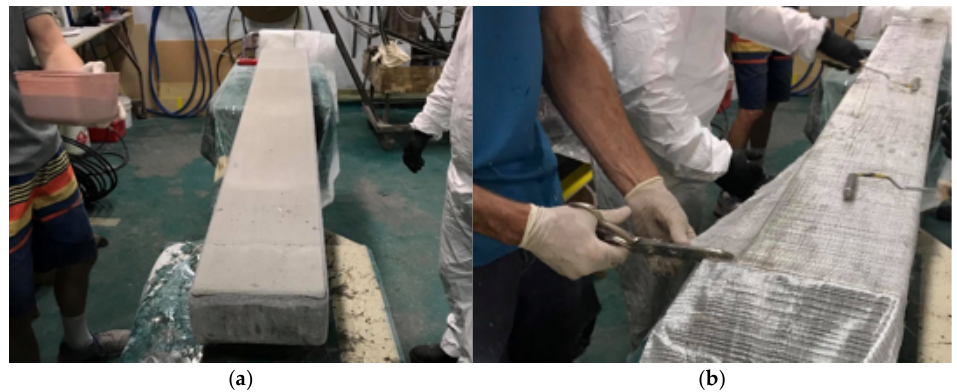
Figure 2. Manufacturing process. ( a ) Prefabricated PU foam core. ( b ) Applying GFRP fabrics on PU core.